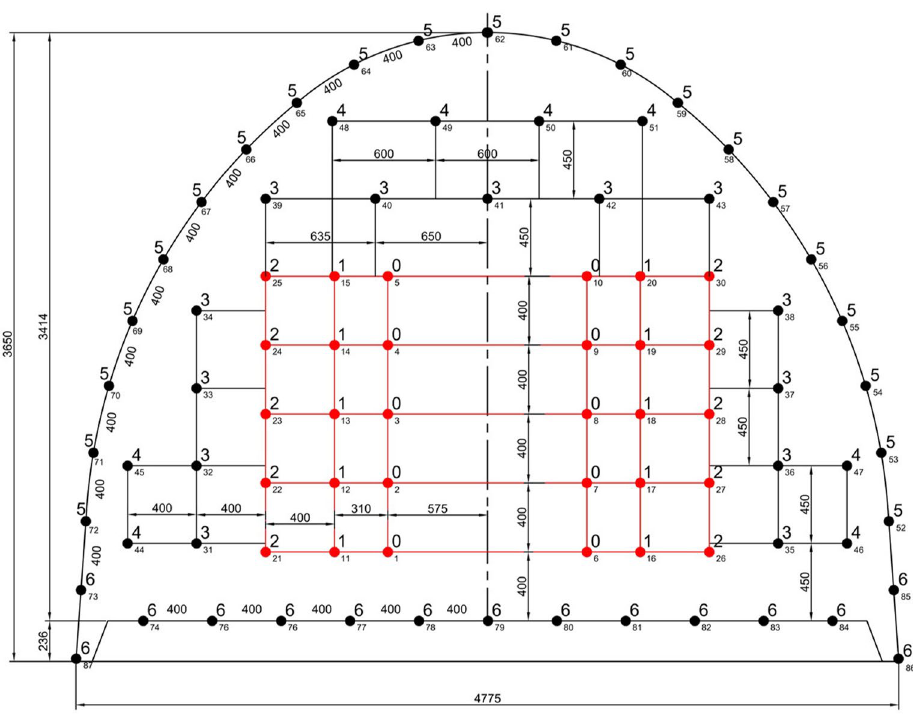
Figure 15. The arrangement of blastholes and firing sequences in excavation of 12.5 m 2 cross-section for a double V cut